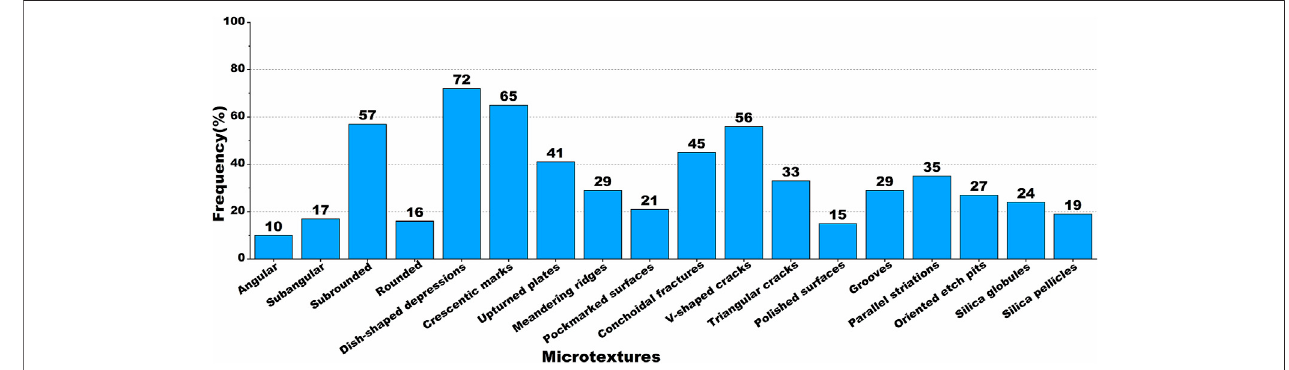
FIGURE 6 | Frequencies of microtextures identi fi ed in QF pro fi